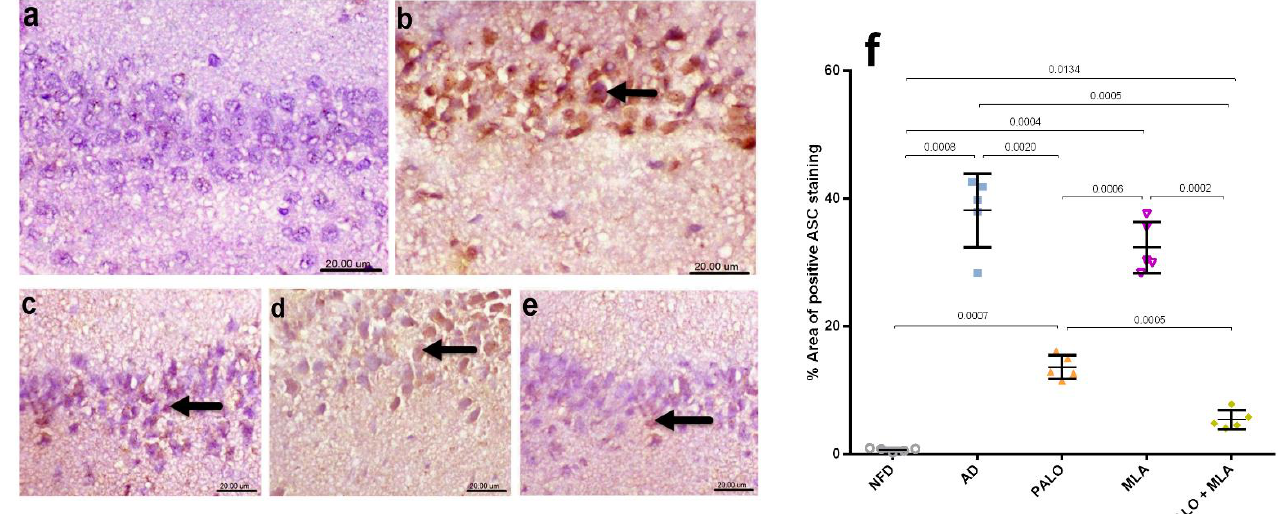
Figure 6. Effect of PALO and/or MLA on hippocampal CA1 immune-histopathological examination of ASC/TMS1 expression in HFFD/LPS-induced AD model. Immunohistochemical analysis of ASC in the CA1 region of hippocampus of rats reveals no ASC expression in the ( a ) NFD, while section of ( b ) AD group shows strong intracellular immune reaction presented by brown immunostaining expression (arrow). Section of ( c ) PALO treated group shows mild ASC expression (arrow), whereas section of ( d ) MLA treated group depicts moderate intracellular ASC expression (arrow). However, section from ( e ) PALO + MLA treated group shows a very weak ASC expression (arrow) (Scale bar 20 µ m, × 600). Panel ( f ) represents the percent area expression from 5 randomly chosen fields in each section. Data were analyzed using one-way ANOVA followed by Tukey’s post hoc test; p < 0.05. PALO (0.1 mg · kg − 1 ; i.p) and/or MLA (5.6 mg · kg − 1 ; i.p) were administered 3 h after LPS injection and for 8